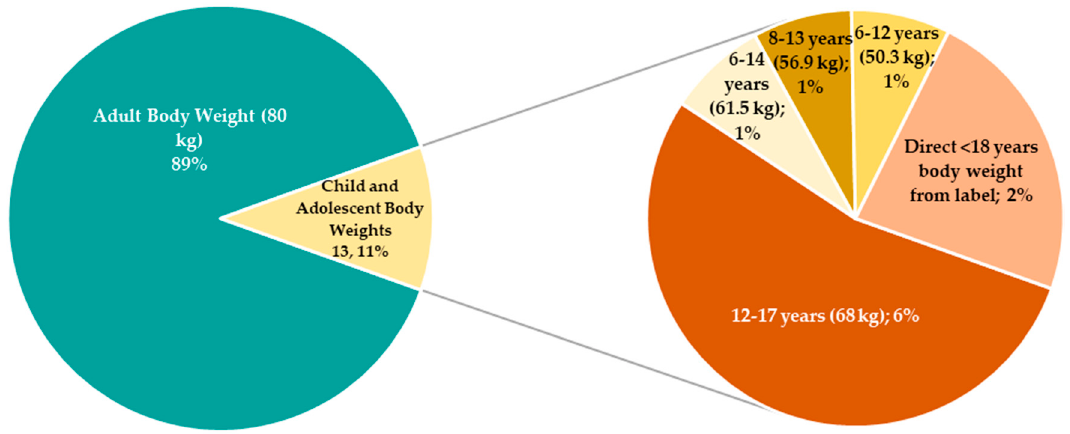
Figure 2. Breakdown of Dosing Basis for Lowest Therapeutic Dose Calculations for the 119 APIs Evaluated. The child and adolescent body weights are based on averages for the ranges [21,22] presented in Table